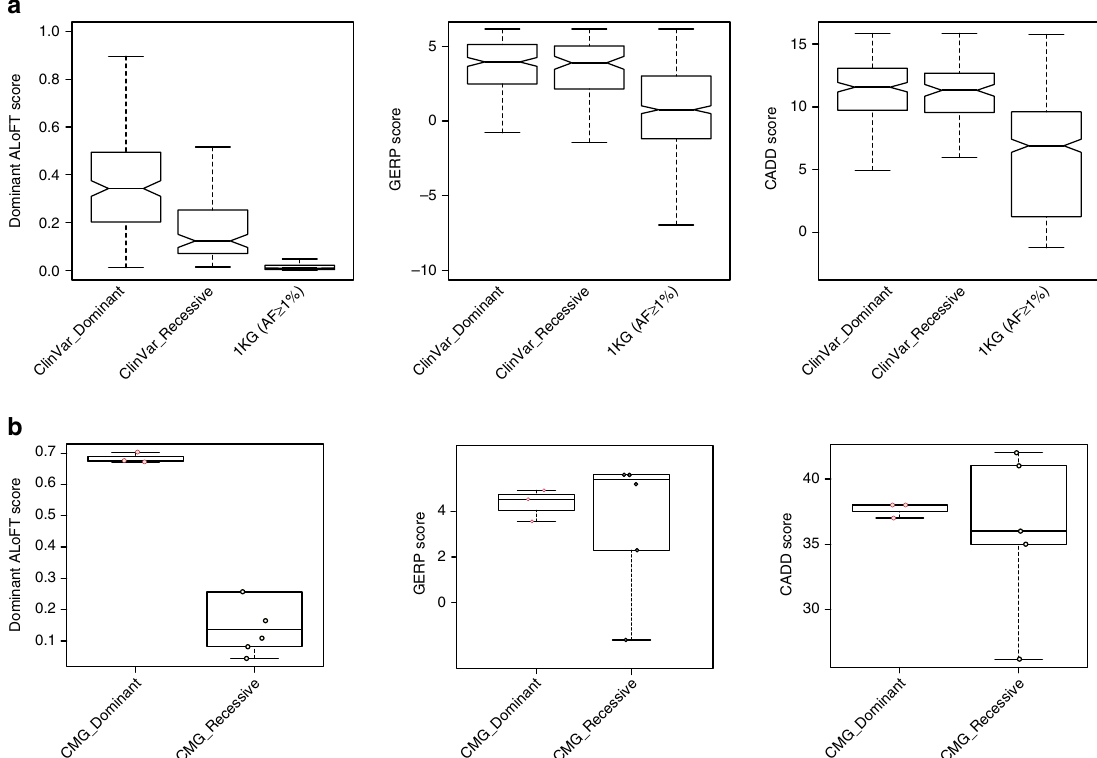
Fig. 2 ALoFT classi fi cation of pathogenic premature stop variants from Mendelian disease studies. a Dominant ALoFT, GERP, and CADD scores for ClinVar and 1KG common (AF ⩾ 1%) variants. All training variants are excluded. Average benign ALoFT scores are 0.097 and 0.115, respectively, for ClinVar dominant and recessive data sets. AF denotes Allele Frequency. 1KG stands for 1000 Genomes Phase1 data. b Dominant ALoFT, GERP, and CADD scores for pathogenic variants from the CMG studies. In these plots, the center line represents the median value of the data, the box goes from the fi rst quartile to the third quartile. The lower whisker goes from Q1 to the smallest non-outlier in the data set, and the upper whisker goes from Q3 to the largest non-outlier in the data set. In addition, the data points are also plotted as open